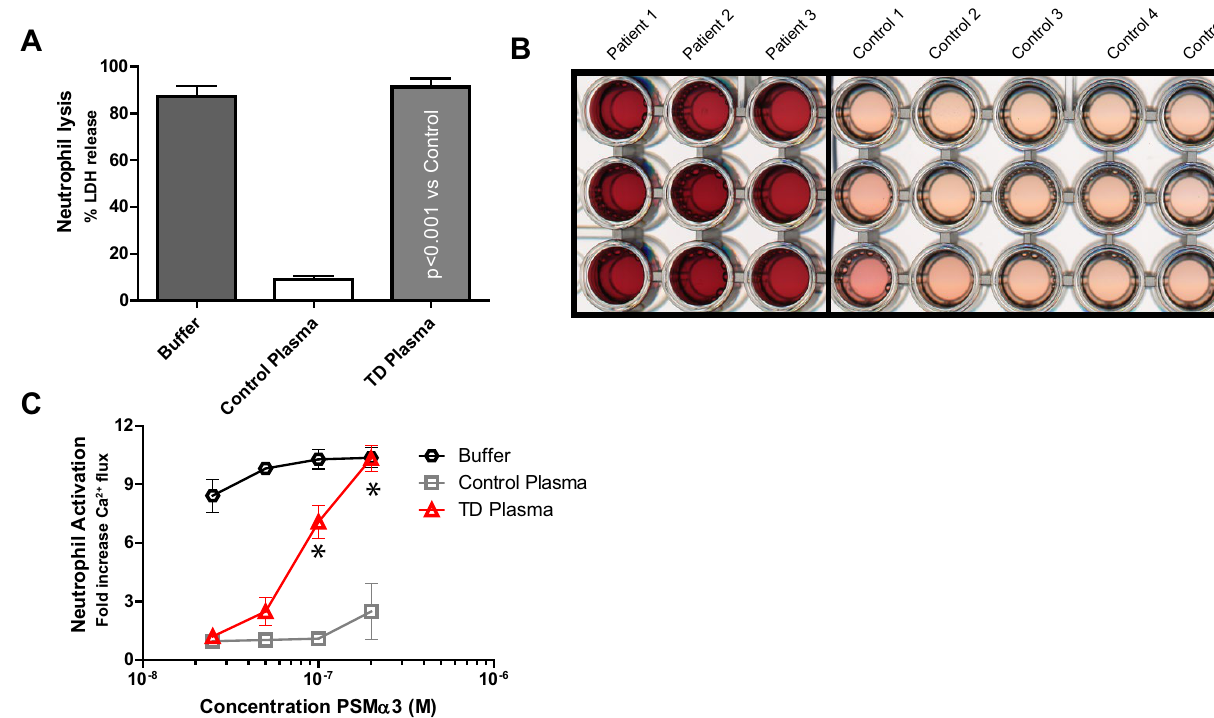
Figure 5. Reduced protection against PSM-induced neutrophil activation and lysis by plasma from Tangier patients. ( A ) PSMα3 (10 µM) induced human neutrophil lysis after preincubation with 0.5% plasma from three different Tangier disease (TD) patients and five healthy control donors. Neutrophil lysis was measured through LDH release. ( B ) Representative photograph of 1 out of 3 neutrophil lysis experiments, as explained under A. ( C ) Calcium mobilization of HL-60/FPR2 stimulated with (25 – 200 nm PSMα3) with and without pretreatment with 0.01% Tangier disease (TD) plasma or control plasma. Calcium mobilization was measured by flow cytometry. * Indicate statistical significance of p < 0.01 One-way ANOVA. Data represent means ± SEM of 3 independent